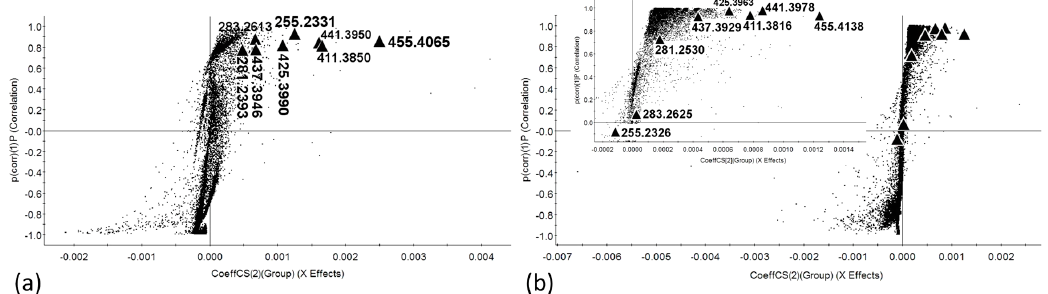
Figure 2. S-plots obtained by OPLS-DA of JI64 a JI92 genotypes. ( a ) Matrix free experiments; ( b ) matrix assisted experiments (inset in ( b ) shows zoomed dormant part of the appropriate S-plot); enlarged triangles indicate identified markers of physical dormancy. Table 1. List of fatty acids found among dormant markers by LDI-MS, MALDI-MS and OPLS-DA analysis. (* deviation of measured mass ( m / z ) from theoretical value calculated from elemental composition).